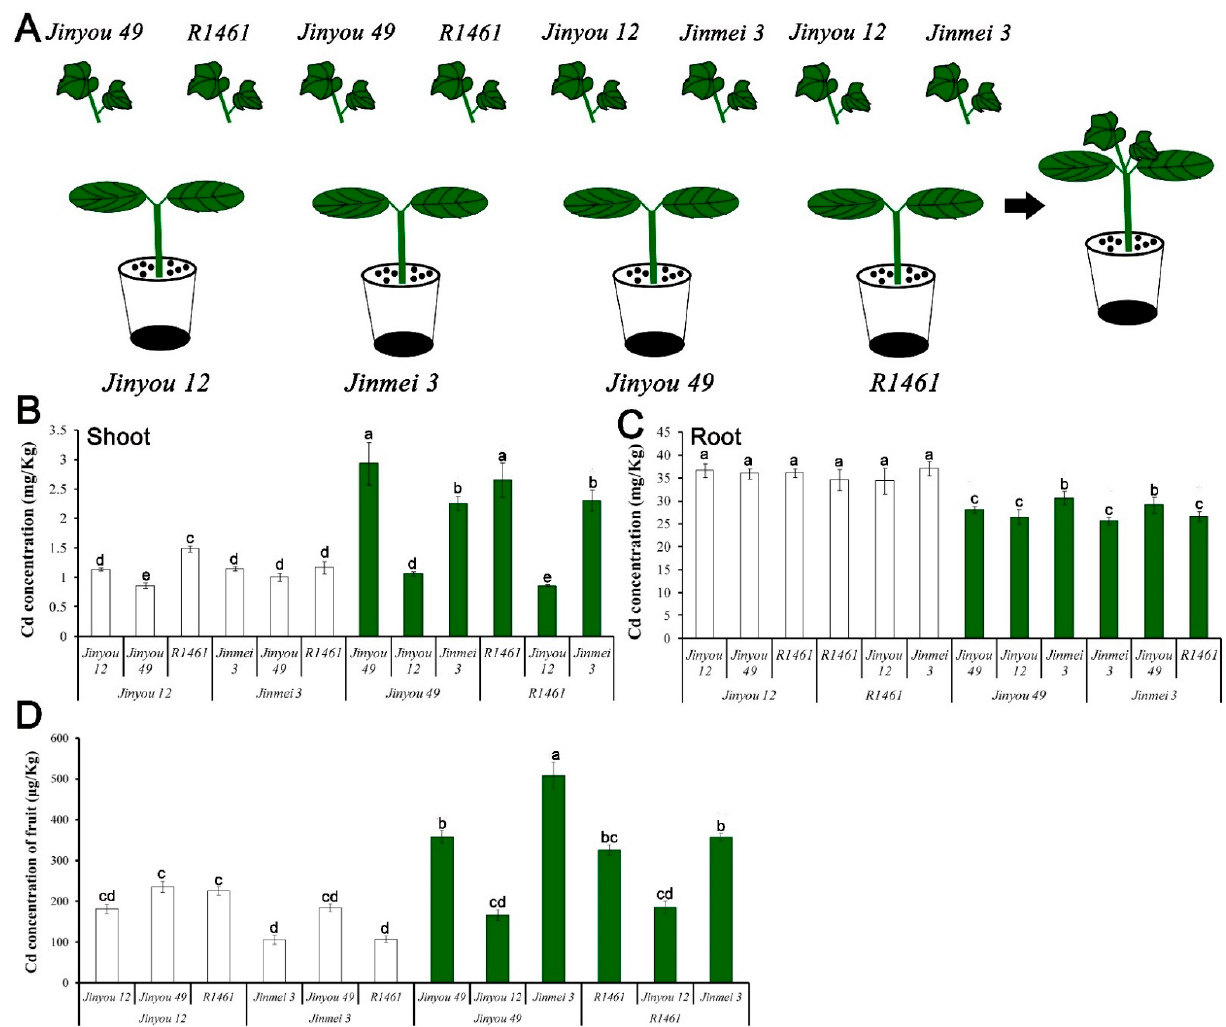
Figure 6. Cadmium accumulation in the roots, shoots, and fruits of cucumber with different grafting combinations exposed to Cd stress. ( A ) Diagram of cucumber grafting combination. ( B – D ) Distribution of Cd content in the shoots ( B ), roots ( C ), and fruits ( D ) of cucumber with different graft combinations under 0.5 µ M Cd treatment. Ten-day-old cucumber plants were selected for grafting. After 7 days of growth in the vermiculite surrounded by Yamazaki nutrient solution, the live seedlings were supplemented with 0 and 0.5 µ M Cd for 48 h and 4day. Vertical bars represent the standard deviation of three replicates. Different letters on the bars indicate that the mean values are significantly different between Jinyou12 lines and other combinations ( p <